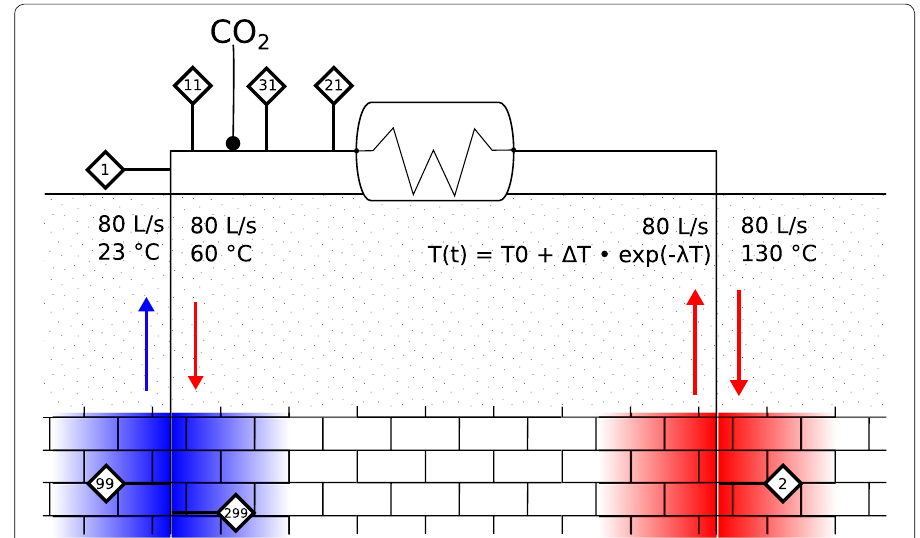
Fig. 4 Conceptual model of an ATES as doublet system including simulation checkpoints